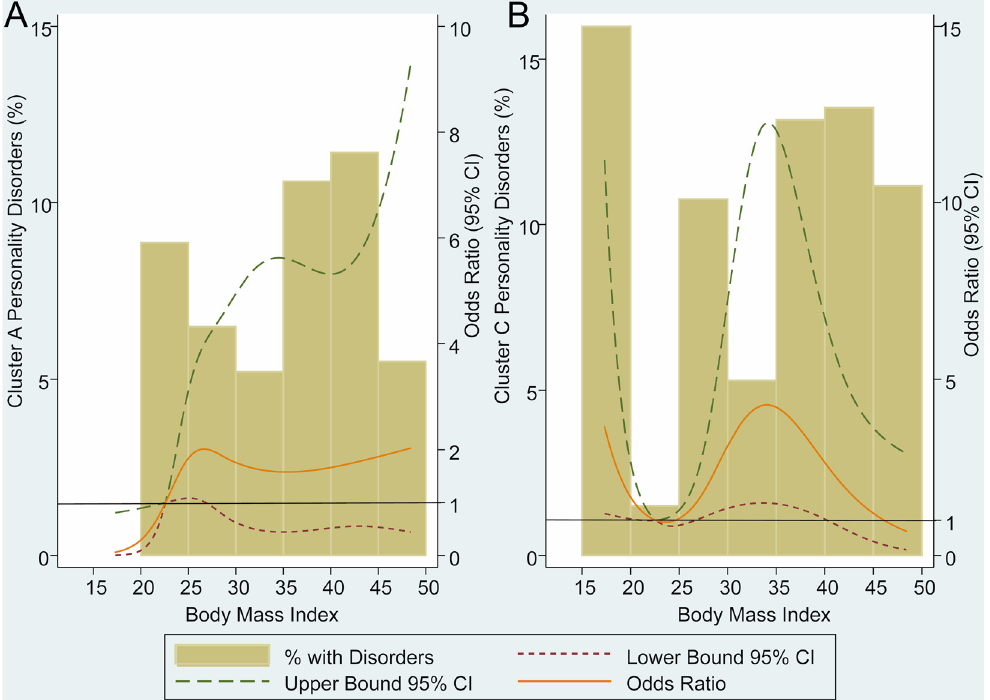
Fig 4. Odds ratio and percentage of cluster A and C personality disorders across the continuum of BMI. (A) Adjusted by age, gender, paid work, educational level, family history of psychiatric disease and substance-related disorders; (B) Adjusted by age, gender, live alone, family history of obesity, family history of psychiatric disease, anxiety and eating disorders; CI = confidence